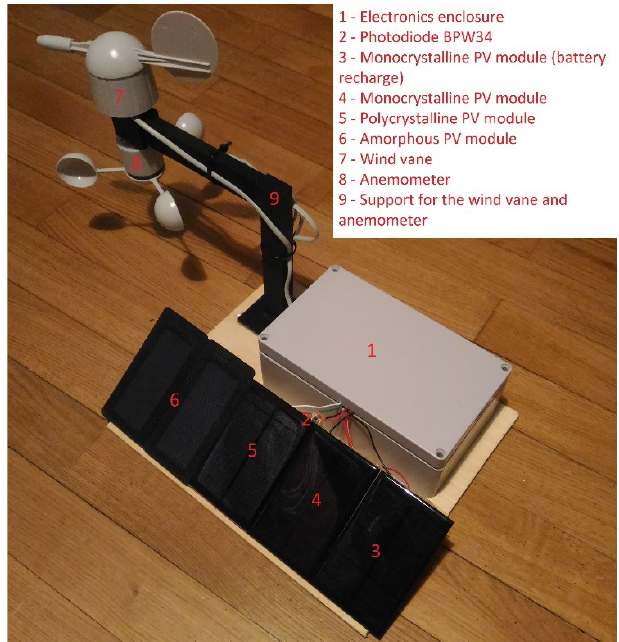
Figure 8. Developed prototype of the weather station.